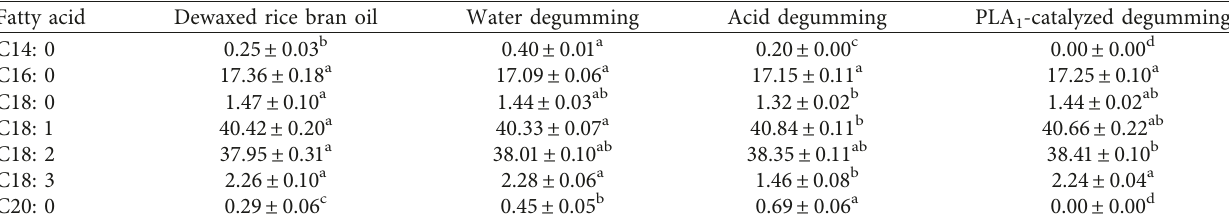
Table 2: Effect of degumming methods on fatty acid composition.